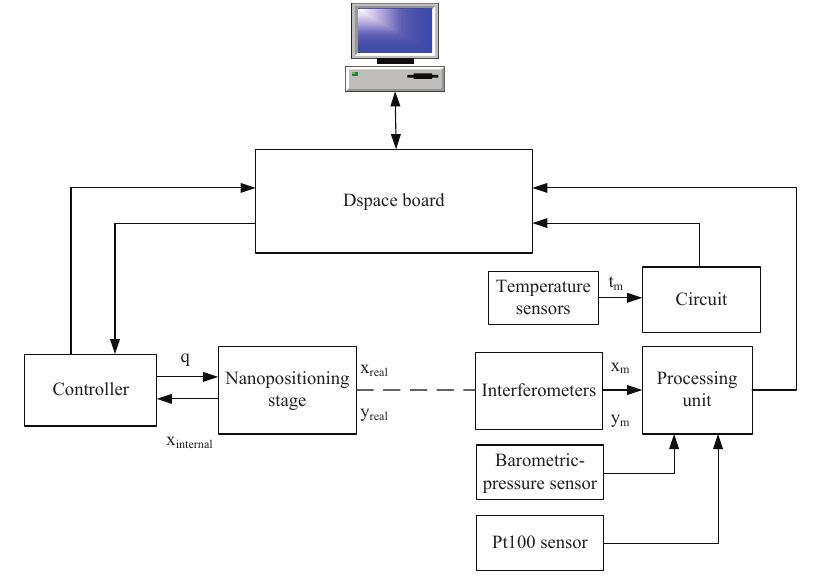
Figure 7. Schematic diagram of the hardware allocation and signal